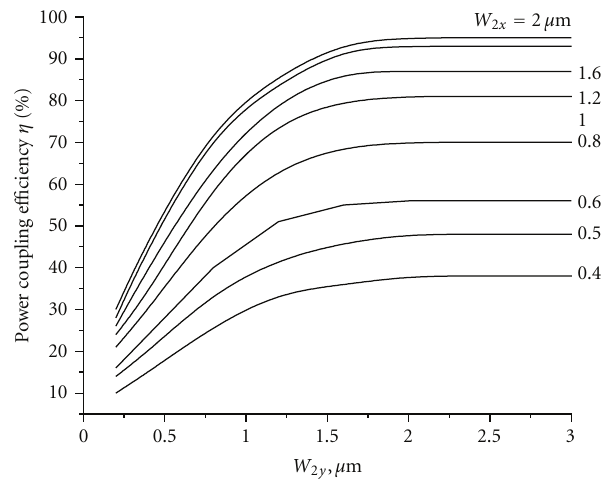
Figure 8: Power coupling e ffi ciency η is shown as a function of beam halfwidth ω 2 x at the beam waist for di ff erent beam halfwidth ω 2 y at the beam waist. The wave length of the Gaussian beam 0.8 μ m, the fibre parameters are n 1 = 1 . 45, Δ = 1% and NA = 0 .